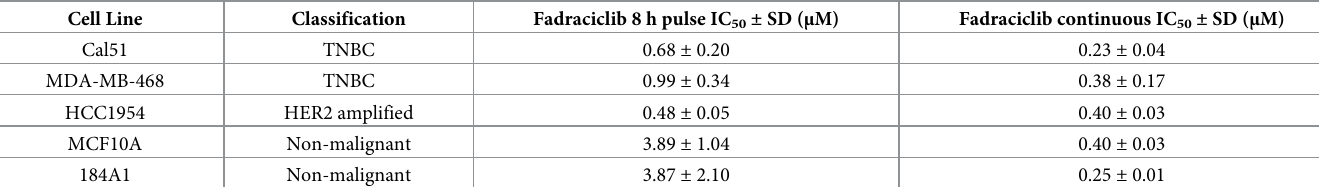
Table 2. Short pulse treatment with fadraciclib (CYC065) reveals a therapeutic window in vitro .